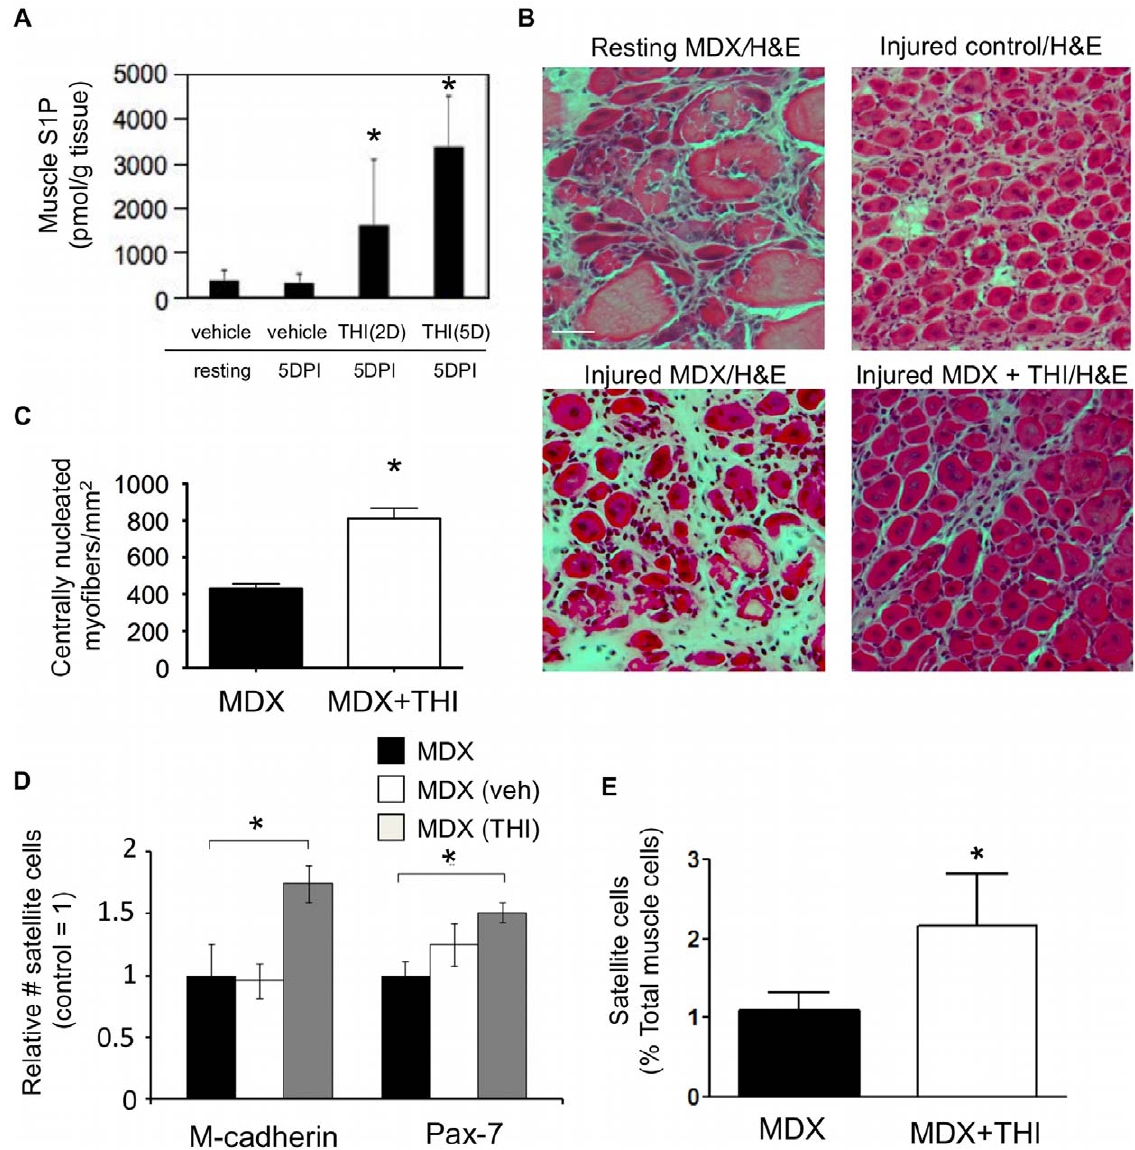
Figure 5. SPL inhibition improves muscle regeneration and SC recruitment in MD. A) Treatment of WT mice with THI for 2 days (2D) or 5 days (5D) results in elevated muscle S1P levels compared to vehicle-treated controls at 5 days post injury (5DPI); * indicates p # 0.05. Data are means 6 SD, n=4–5/group. B) Mdx mice received NTX + THI or vehicle daily on days 2 1 to 5. On day 5, mice were euthanized and gastrocnemius muscles were harvested. Ten m m tissue cryosections were obtained every 200 m m in sets of 4. H&E stained sections were examined for point of maximal injury. Representative photographs are shown. Scale bar=50 microns. Recovering WT control and resting mdx muscles are shown for comparison. C) Fiber quantification of experiment in ‘‘B’’. Centrally nucleated myofibers were counted in a field containing only regenerating fibers and normalized